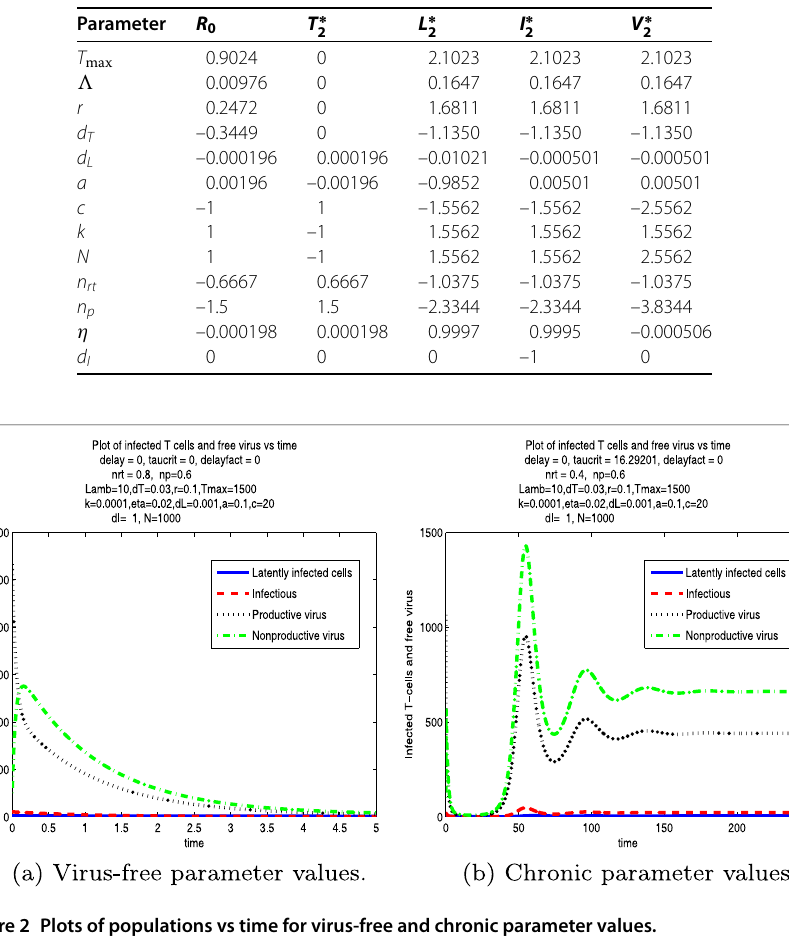
Table 14 Sensitivity indices for chronic infected T-cells and virus populations for R 0 > 1